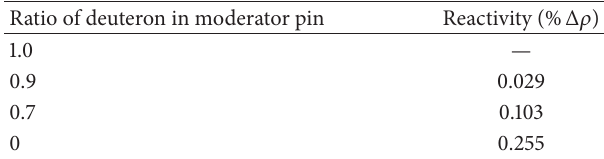
Table 8: Reactivity insertion occurred at dissolution of deuteron. Ratio of deuteron in moderator